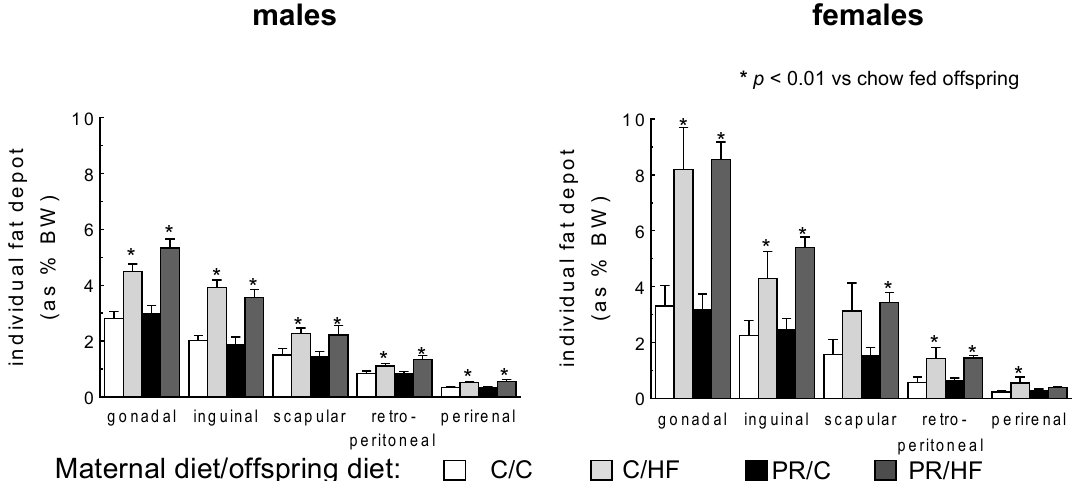
Figure 2. Weight of individual fat depots (expressed as % of total body weight) in male and female offspring from dams on standard chow (C) or protein restricted (PR) diet during pregnancy. Weaned offspring were then fed either a high fat (HF) or C diet to adulthood, thus generating the dam/offspring dietary groups: C/C, C/HF, PR/C and PR/HF. All values are reported as means ± SEM. (n = 7–11 per group) and analysed using a one-way ANOVA with Tukey–Kramer post hoc test.